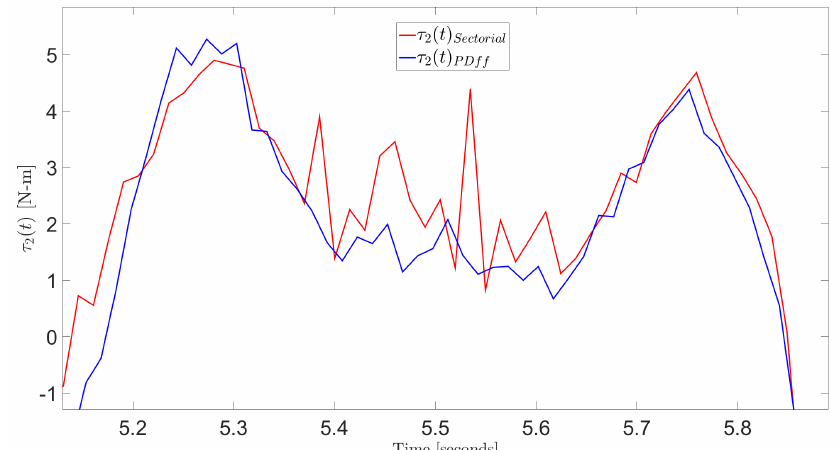
Figure 29. Magnification of applied torque to joint 2 showing visual artifacts created by using a different output delivery sampling